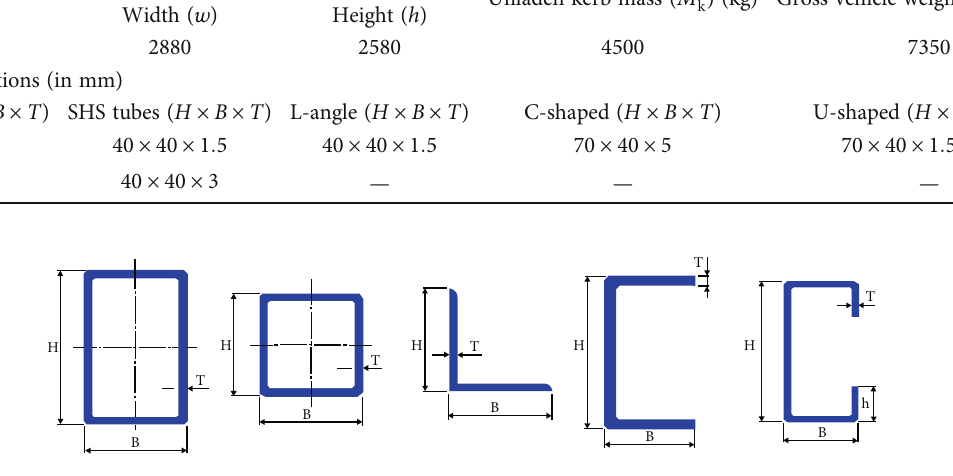
Figure 2: Geometrical con fi gurations of cross sections.